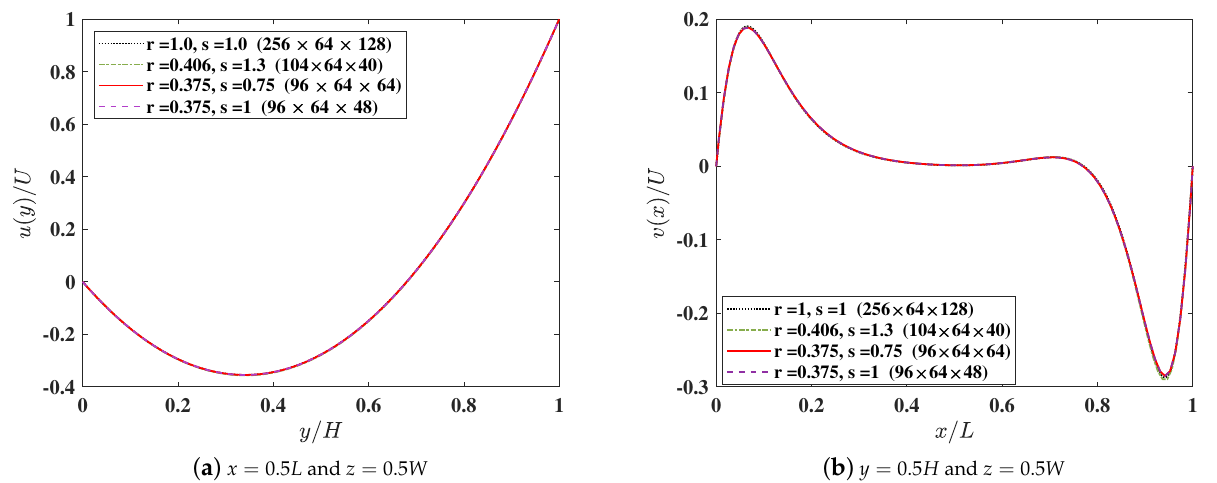
Figure 10. The velocity profiles along the centerlines of a 3D shallow lid driven cavity of aspect ratio L / H = 2 and L / W = 4 at a Reynolds number Re = 100 computed using 3DCCM-LBM with the cubic lattice ( r = s = 1 ) and a cuboid lattice with the following three different choices o fthe grid aspect ratios: ( r , s ) = ( 0.406,1.3 ) , ( r , s ) = ( 0.375,0.75 ) , and ( r , s ) = ( 0.375,1.0 ) . ( a ) u component along the y direction at x = 0.5 L and z = 0.5 W , and ( b ) v component along the x direction at y = 0.5 H and z = 0.5 W .